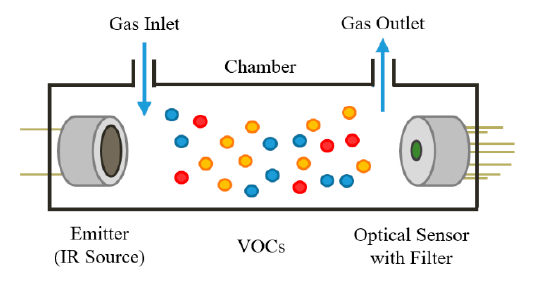
Figure 2. Optical gas sensing principle. Table 1. List of sensors used in the optical electronic nose.